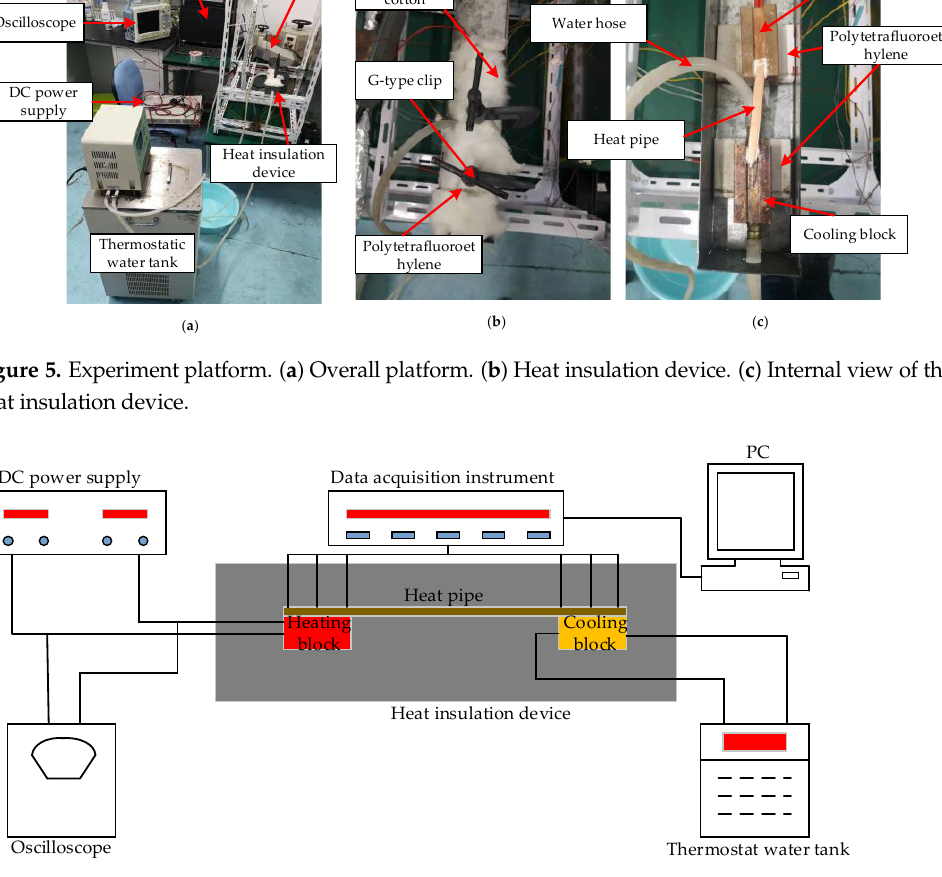
Figure 7. Experimental result of the property test of the heat pipe. The equivalent thermal conductivity of the heat pipe is calculated according to the following formula: